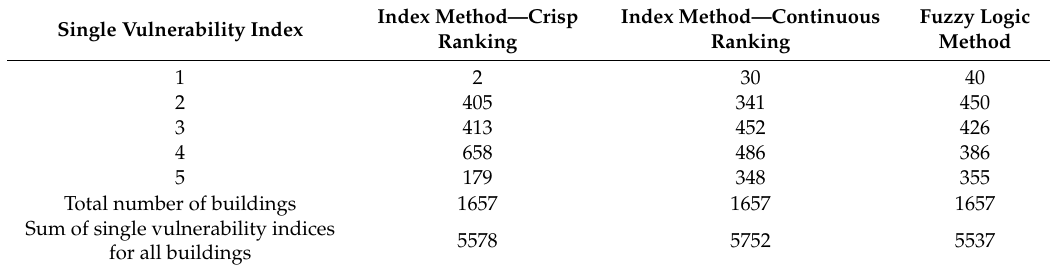
Table 5. Numbers of buildings with vulnerability index 1, 2, 3, 4, and 5, calculated by the three methods. Single Vulnerability